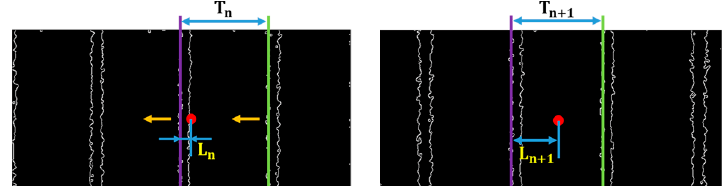
Figure 10. Phase calculation method: ( a ) edge of the n th interferogram; and ( b ) edge of the (n + 1)th interferogram.